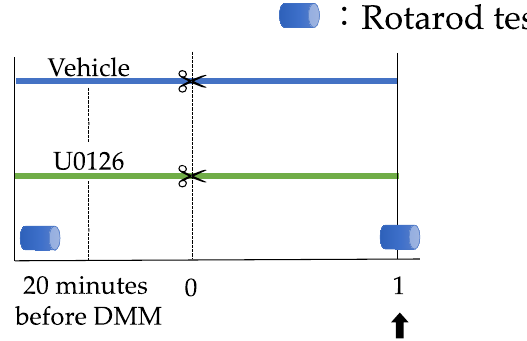
Figure 2. Protocol of Experiment 2. Contribution of ERK1/2 phosphorylation to pain-related locomotive dysfunction with DMM surgery was examined. After the rotarod test, U0126 (5 µg/10 µL) was intrathecally administered 20 min before the DMM surgery (DMM + U0126 group), and 10 µL of 20% DMSO was injected as a vehicle control (DMM + vehicle group). One day after the surgery, the spinal cord at the L2–L4 level was harvested for Western blotting to measure ERK1/2 phosphorylation. ERK, extracellular signal-regulated kinase; DMM, destabilization of the medial meniscus, DMSO, dimethyl sulfoxide.